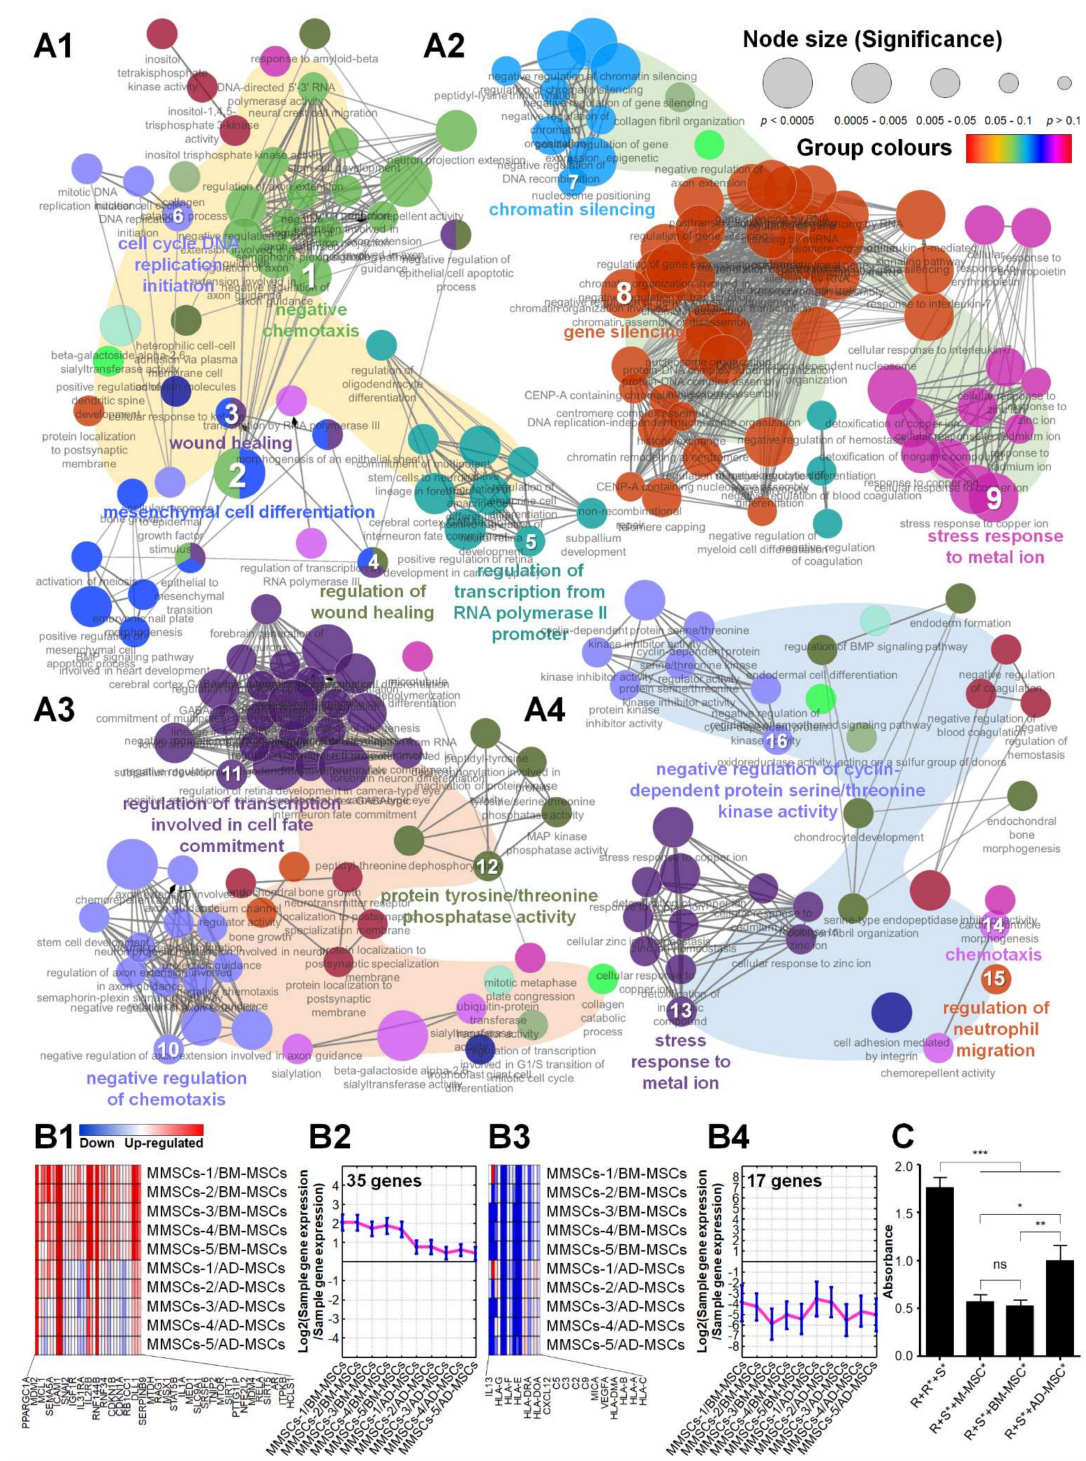
Figure 1. Characterization of M-MSCs compared to adult MSCs. Gene Ontology (GO) network and Enrichment Pathway analysis for M-MSCs were assessed using ClueGO. ( A1 ) Upregulated differ- entially expressed genes (DEGs) (fold change (FC) > 4) and ( A2 ) downregulated DEGs (FC < 0.25) in the M-MSCs compared to BM-MSCs were analyzed, while ( A3 ) upregulated DEGs (FC > 4) and ( A4 ) downregulated DEGs (FC < 0.25) in the M-MSCs compared to AD-MSCs were analyzed. Each node represents a significantly enriched biological process and shows their significance depending on their size. The gene expressions of M-MSCs were compared to adult MSCs for specific